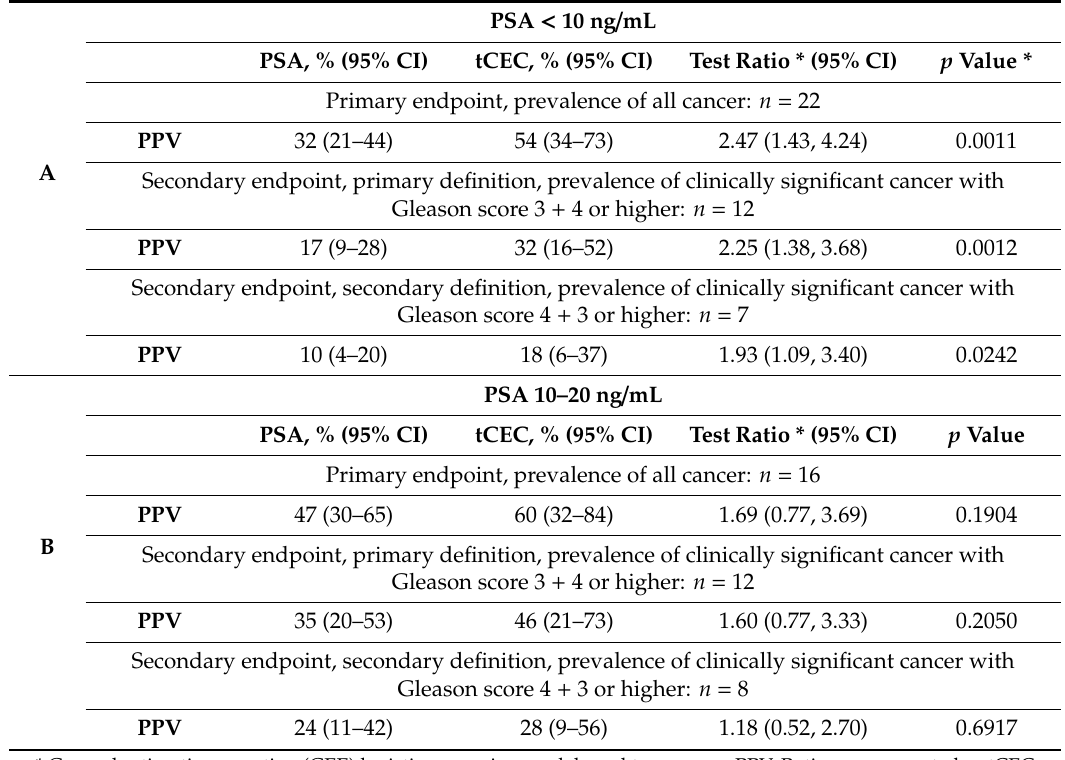
Table 3. Comparison of PPV of PSA and tCEC test for all prostate cancer and clinically significant cancer in men with PSA readings < 10 ng / mL (A) and 10–20 ng / mL (B) according to the primary and secondary definitions. PPV: positive predictive value; PSA: prostate-specific antigen; CI: